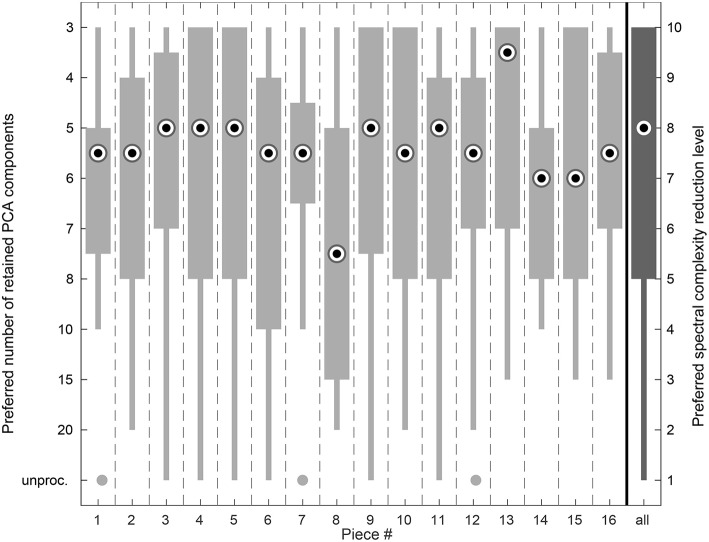
Box plot showing the listening experiment results accumulated over all sessions per piece. The very right column shows the overall distribution of the preference ratings.